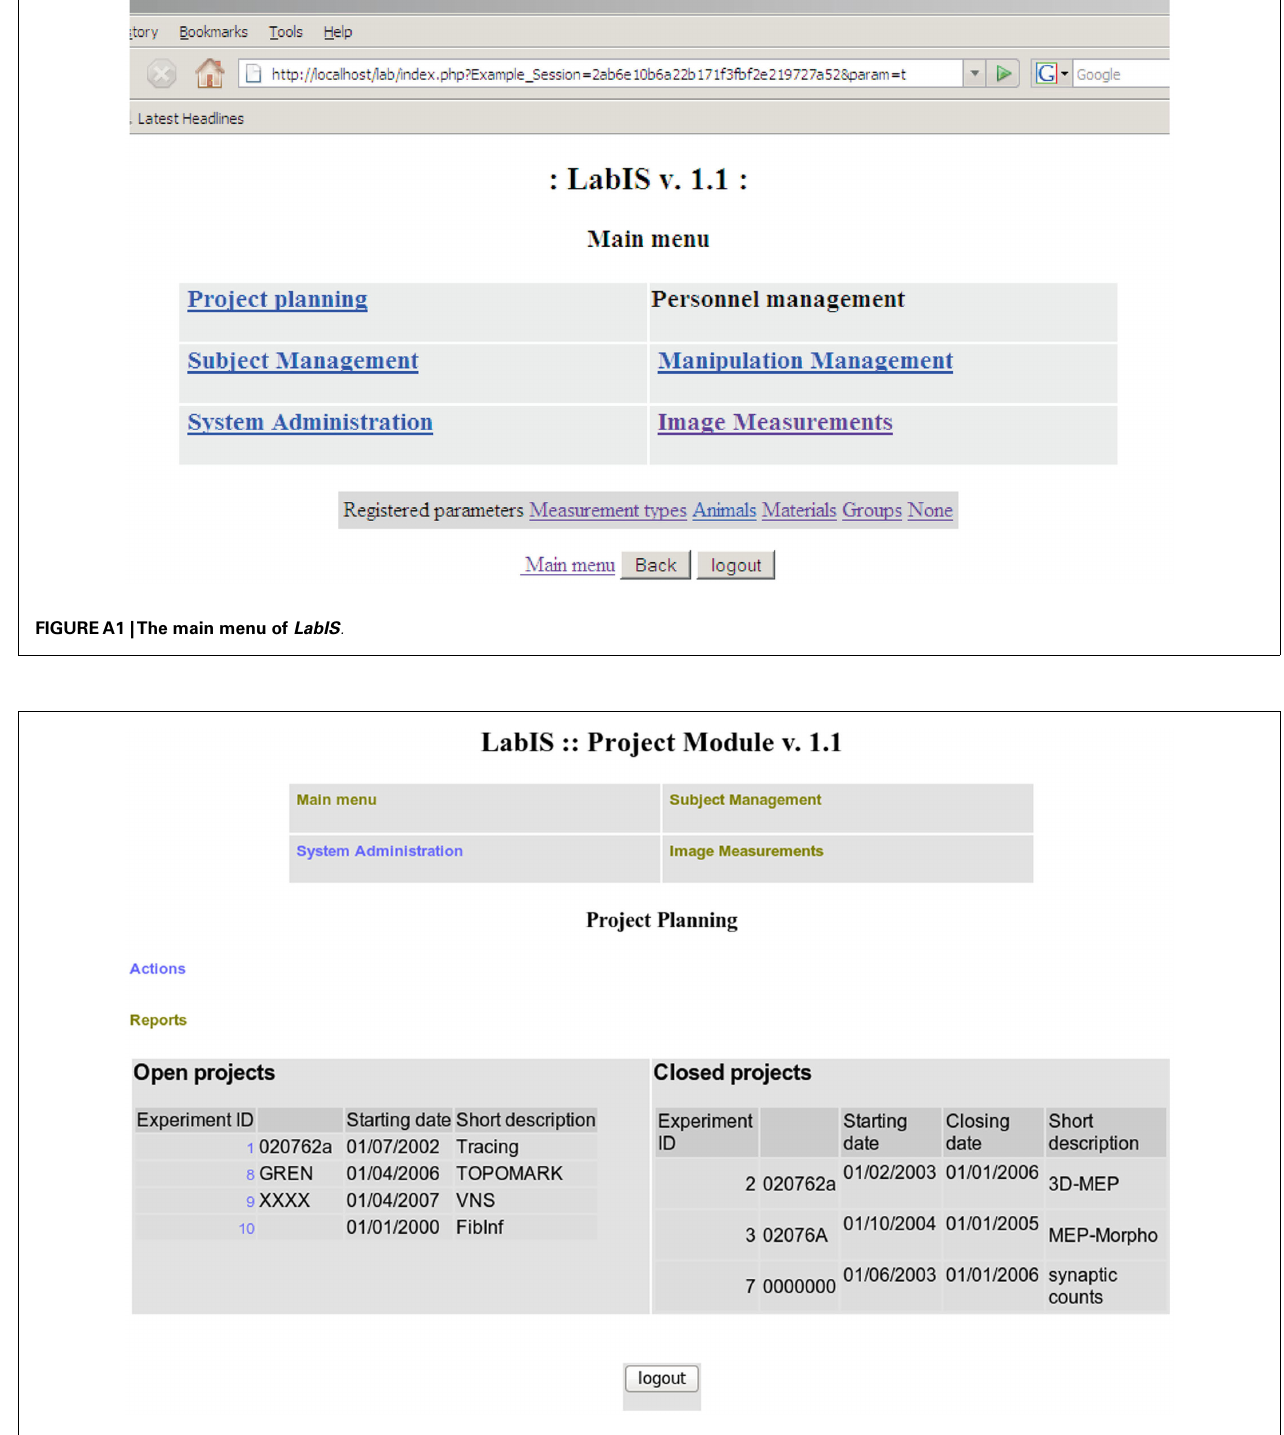
FIGUREA2 |The projects